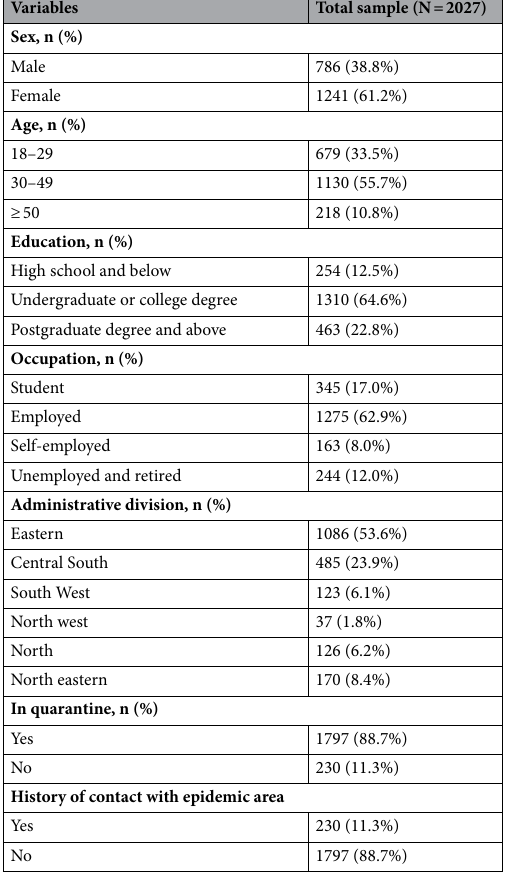
Table 1. Demographic characteristics of the sample.